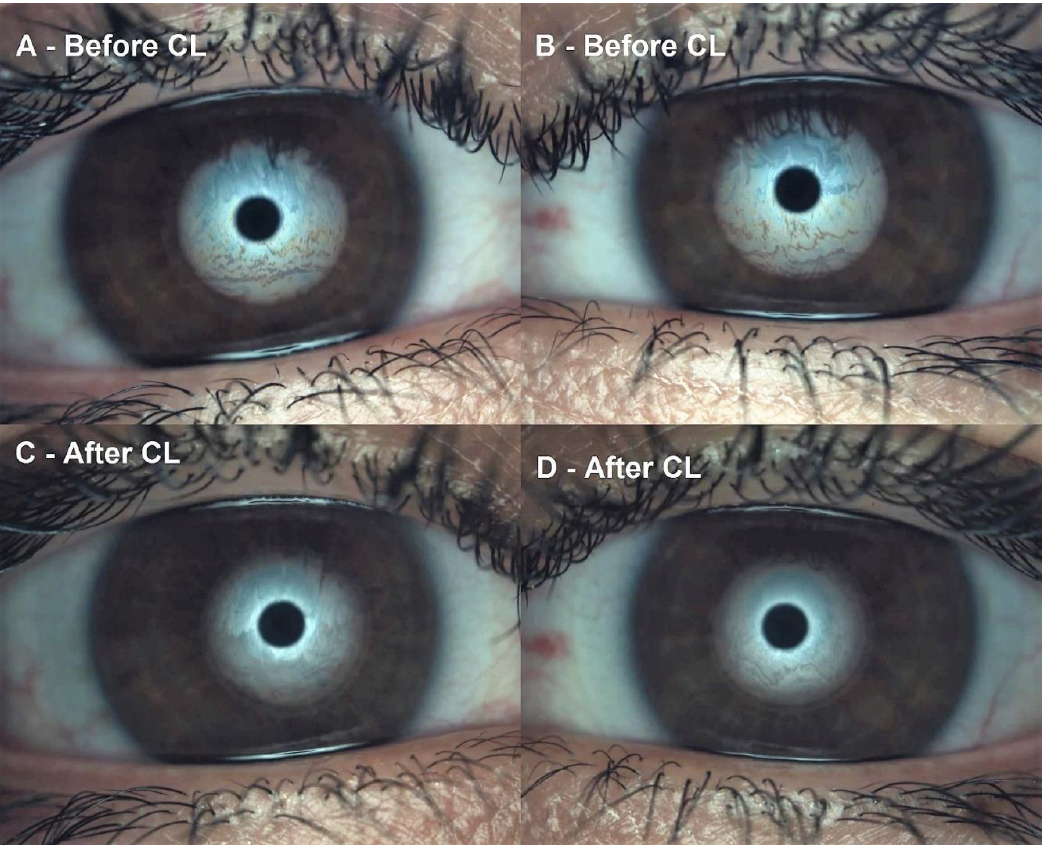
Figure 1. Lipid layer thickness interferometry decreased from grades 5 and 5 to grades 1 and 1: ( A ) Right eye grade 5 Guillon pattern before contact lens, ( B ): Left eye grade 5 Guillon pattern before contact lens. ( C ): Right eye grade 1 Guillon pattern after contact lens and ( D ): Left eye grade 1 Guillon pattern after contact lens. This figure was a singular participant example (subject 12, both eyes).